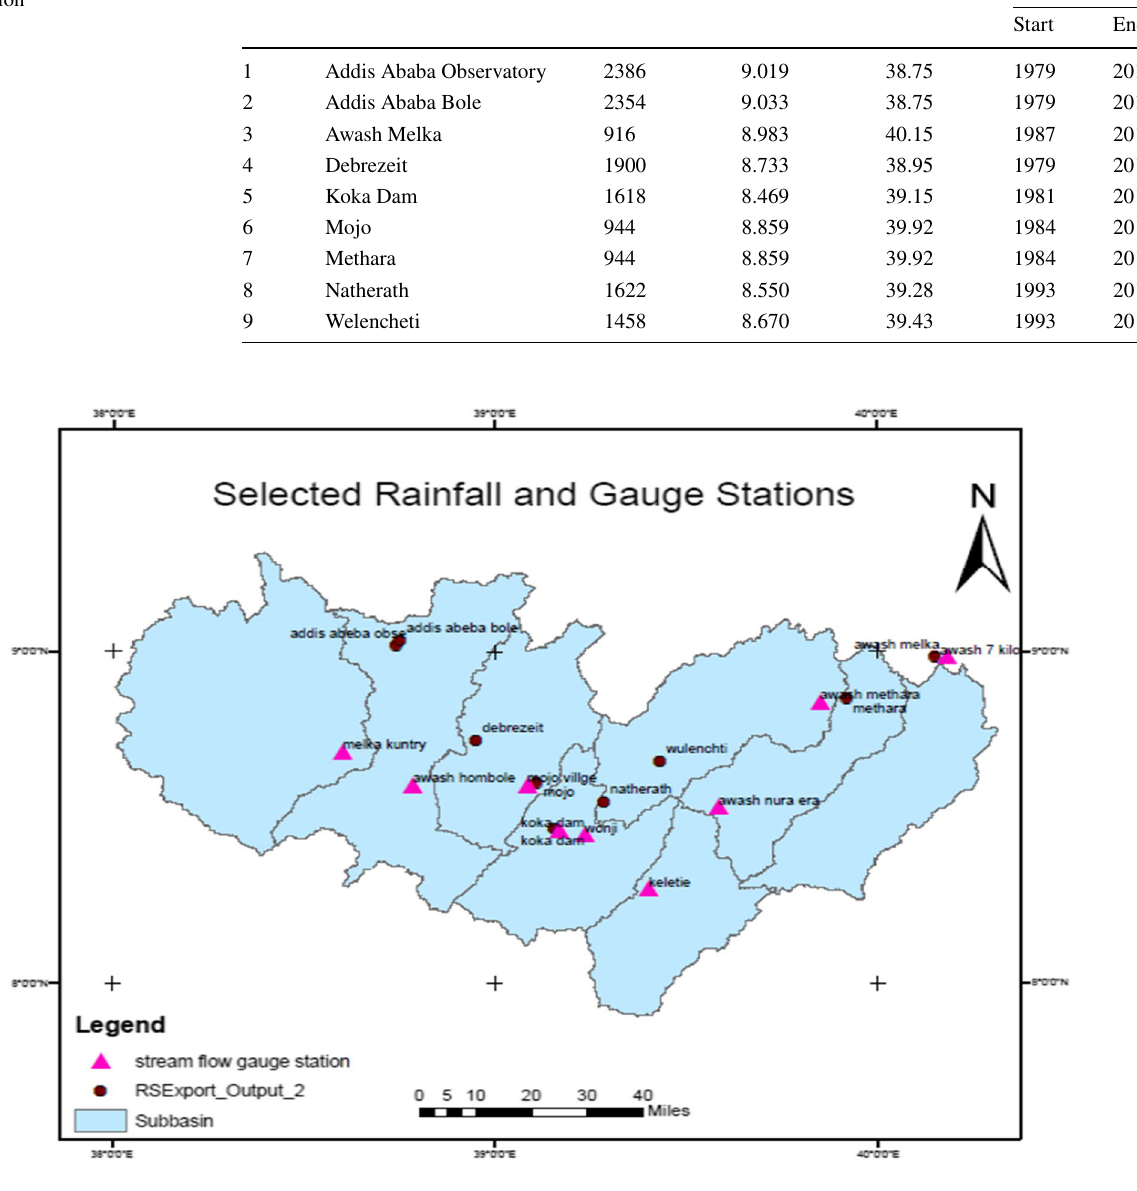
Fig. 2 Hydrological and meteorological stations in and out of the project